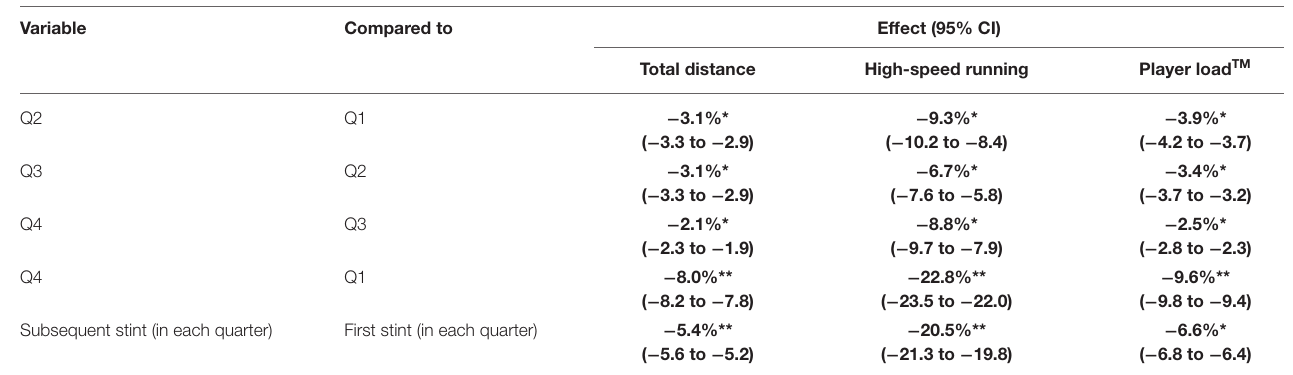
TABLE 4 | The effects of quarters and stint